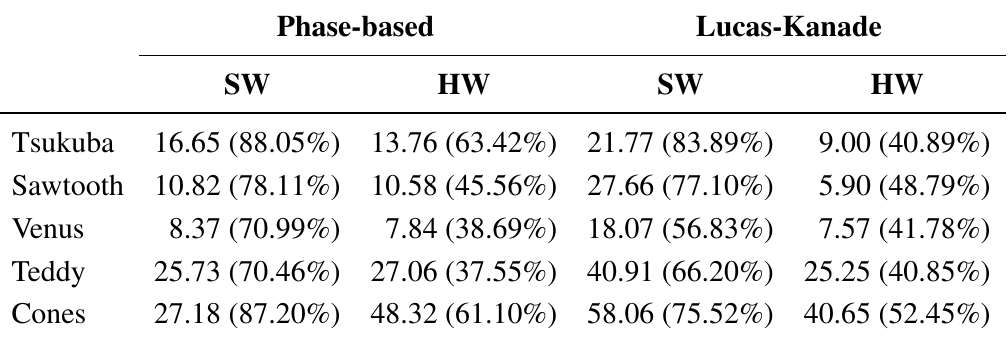
Table 2. Horizontal disparity performances: PoBP(%) percentage of pixels where MAE > 1 and the density between